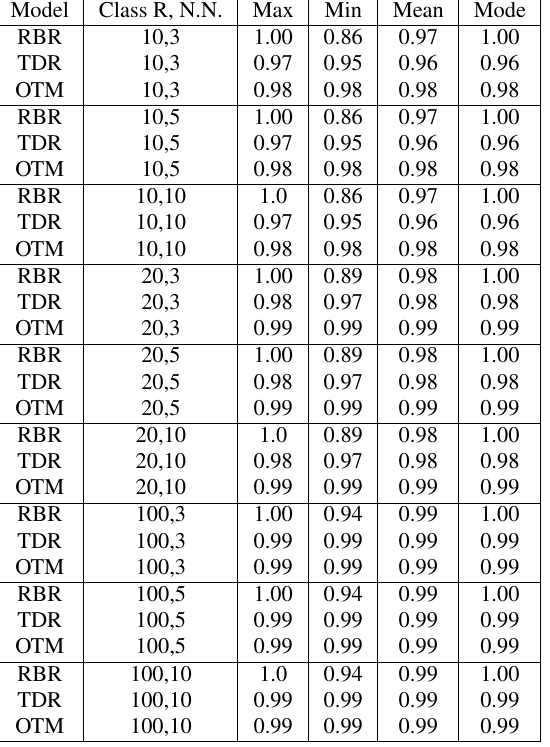
Table 2: Maximum, minimum, mean and mode values of the ac- curacy. RBR: row-by-row updated model, one-row test data ac- curacy, TDR: row-by-row updated model, whole test data row- by-row model accuracy, OTM: once trained MLM model. Class R: number of selected training reference points per class, N.N.: number of neighbours.